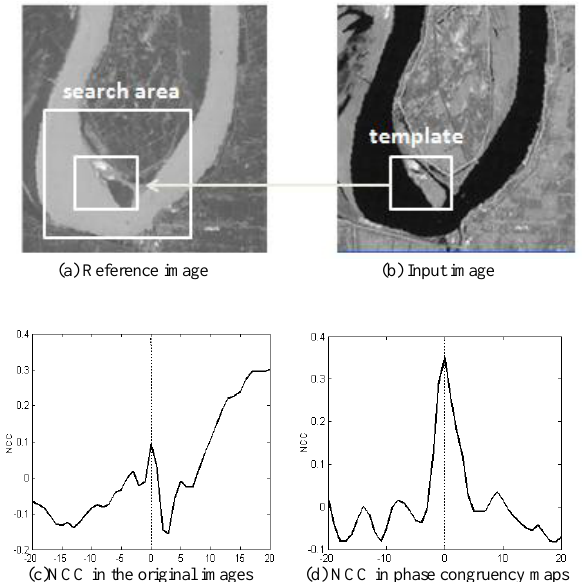
Figure 3: The matching process and the NCC